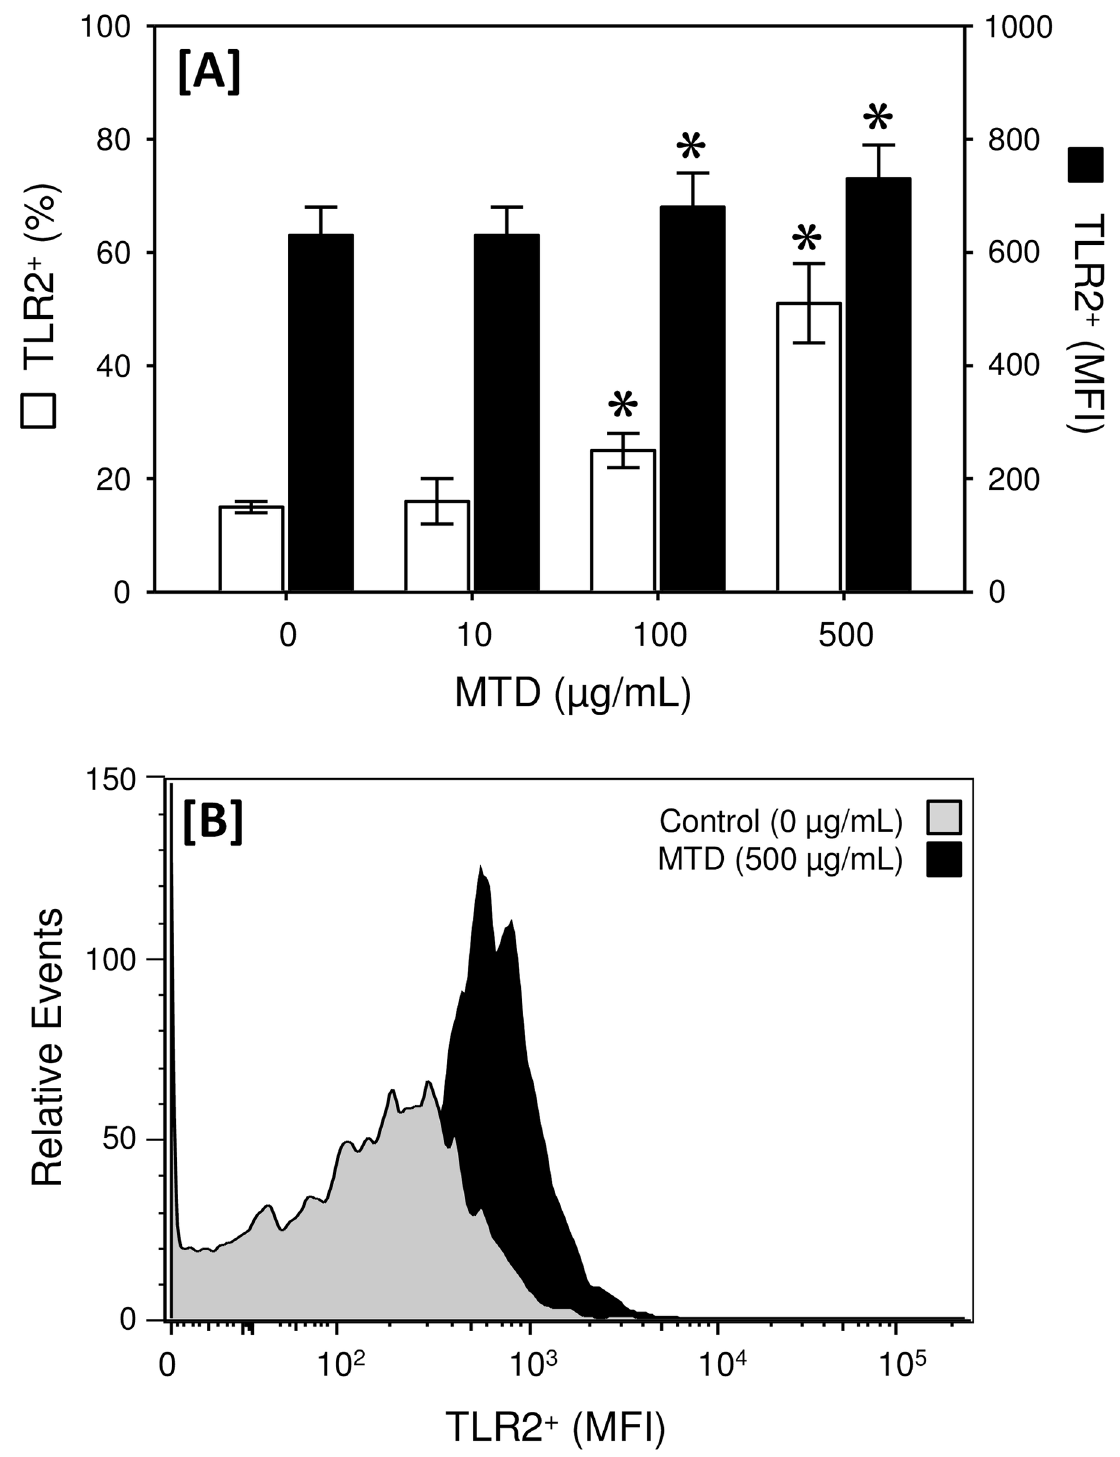
Fig 2. MTDs increase TLR2 expression by dermal γδ T-cell s . Skin T-cells were incubated with MTDs (0 – 500 μ g/mL) and TLR2 expression on the γδ T-cell population was determined by flow cytometry as described in the materials and methods. Panel A shows the percentage of the cells positive for TLR2 expression (TLR2 + ) □ and the mean fluorescence intensity (MFI) of the TLR2 + cells ■ . The data are Mean ± SEM for cells from 5 mice. Panel B shows a representative histogram plot for TLR2 expression by control cells and following stimulation with 500 μ g/mL MTDs. * p < 0.05 as compared with control (0 μ g/mL).